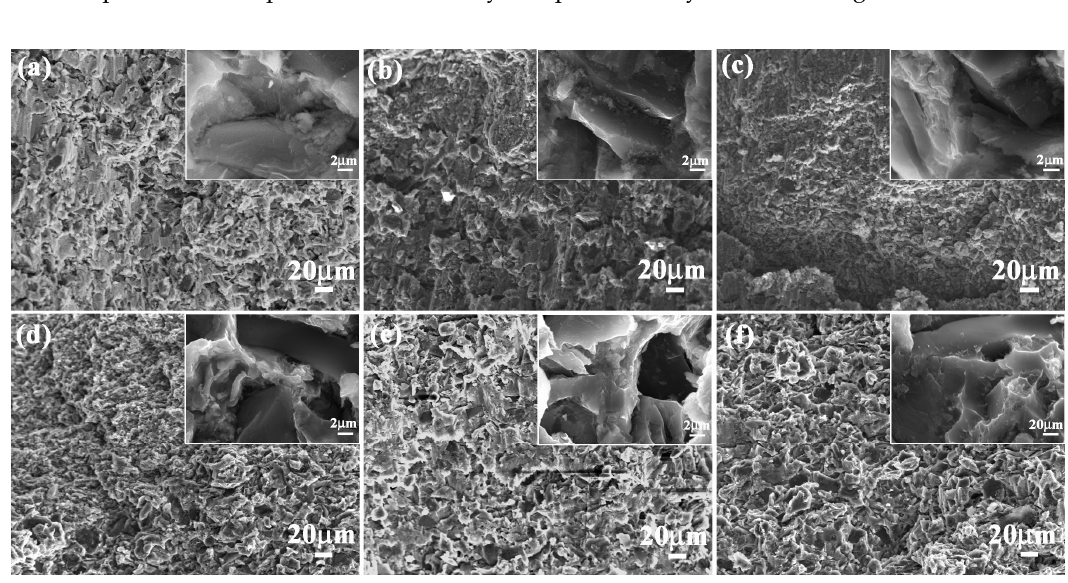
Figure 10. Impact appearance of ( a ) Outer layer; ( b ) Middle layer; and ( c ) Inner layer of bionic Meretrix lusoria shell composite material and ( d ) Outer layer; ( e ) Middle layer; and ( f ) Inner layer of bionic Rapana venosa shell composite material. 4. Conclusions Based on microstructure characteristics of Meretrix lusoria shell and Rapana venosa shell, two kinds of bionic coupling models were established to guide the design and fabrication of bionic coupling layered B 4 C/5083Al composite materials, respectively. Attributed to the coupling between layered structure and hard/soft combination model, the bionic composite materials owned high mechanical properties including flexural strength, fracture toughness, compressive strength and impact toughness: